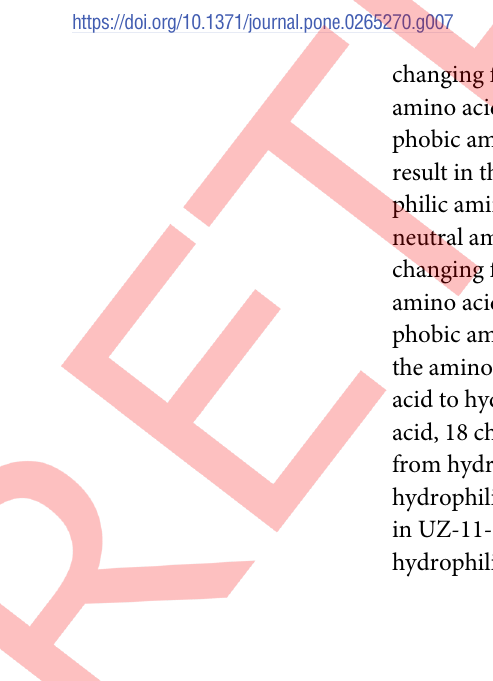
Fig 7. Measurements of gene expression of MORF/RIP by qRT-PCR. The relative gene expression of DEGs by qRT-PCR is represent by bars with standard errors in three independent experiments. Least Significant Difference (LSD) test was used. Different lowercase letters indicate significantly differences at P �